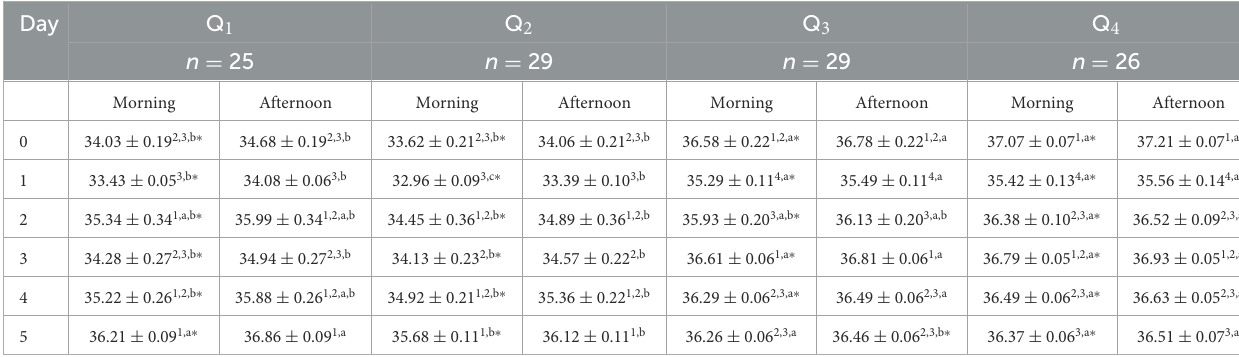
TABLE 4 Mean auditory canal surface temperature ± standard error (SE) in 109 newborn water buffaloes at different birth weights and daytimes (morning/afternoon) during the first 6 days of